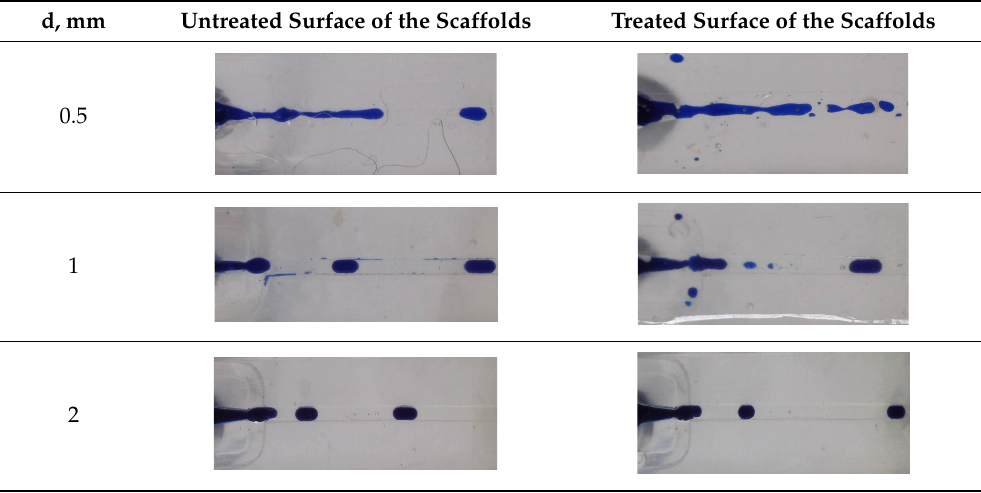
Figure 3. The surface of the scaffolds for ESCARGOT chip with silicone walls (Figure 2c): ( a ) the original surface of the scaffold with traces of 3D printing; ( b ) the surface treated in acetone vapor.